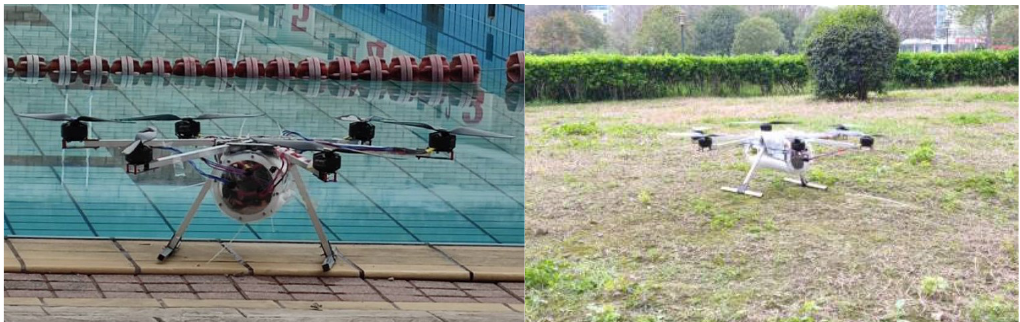
Figure 8. Experimental prototype of an amphibious multi-rotor UAV.